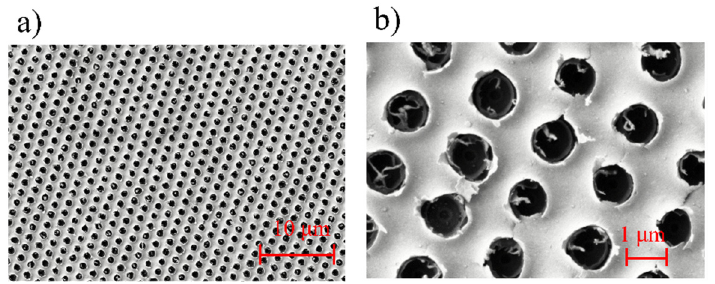
Figure 12. SEM images of the fishnet metamaterial with a periodic square array of circular holes with ( a ) the magnification was 2.5 k; ( b ) the magnification was 15 k.